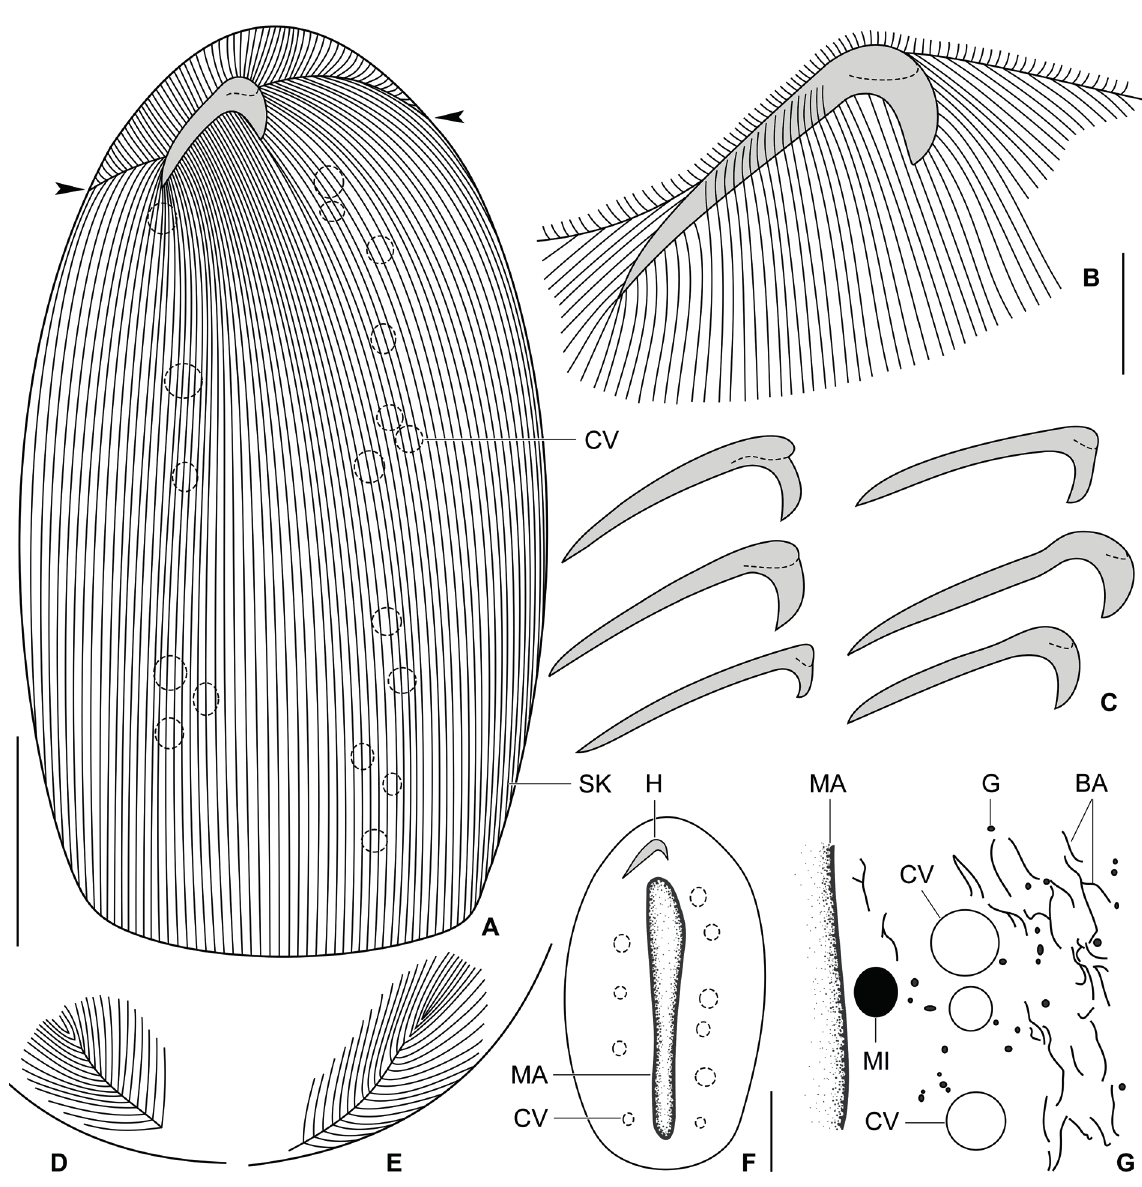
Fig. 2. Metaradiophrya lumbrici (Dujardin, 1841), Slovak specimens in vivo . A . Semi-schematic diagram of the ventral side, showing the fibrillar hook as well as the contractile vacuole and the somatic ciliary pattern. Arrowheads mark the subapical suture extending from the right body margin over the hook towards the left body margin. B . Detail of the anterior body portion, showing the fibrillar hook and its associated fibers. There are on average 6 (5‒7) fibers attached to the upper right side of the longer arm, on average 33 (30‒37) fibers to the ventral side of the longer arm and on average 11 (8‒13) fibers to the left side of the shorter arm. C . Shape variants of fibrillar hooks. The hook is composed of two unequally long arms: the longer arm is flat and 25‒35 µm long, while the shorter arm appears slightly more robust at the base and is 8‒13 µm long. D–E . Lateral somatic kineties form a right and a left subterminal suture in the posterior body region. F . Ventral view, showing the general body organization. G . The cytoplasm contains innumerable granules being ca 0.4 µm across and rod-like bacteria being about 3‒15 µm long. Scale bars: A, F = 50 µm; B = 10